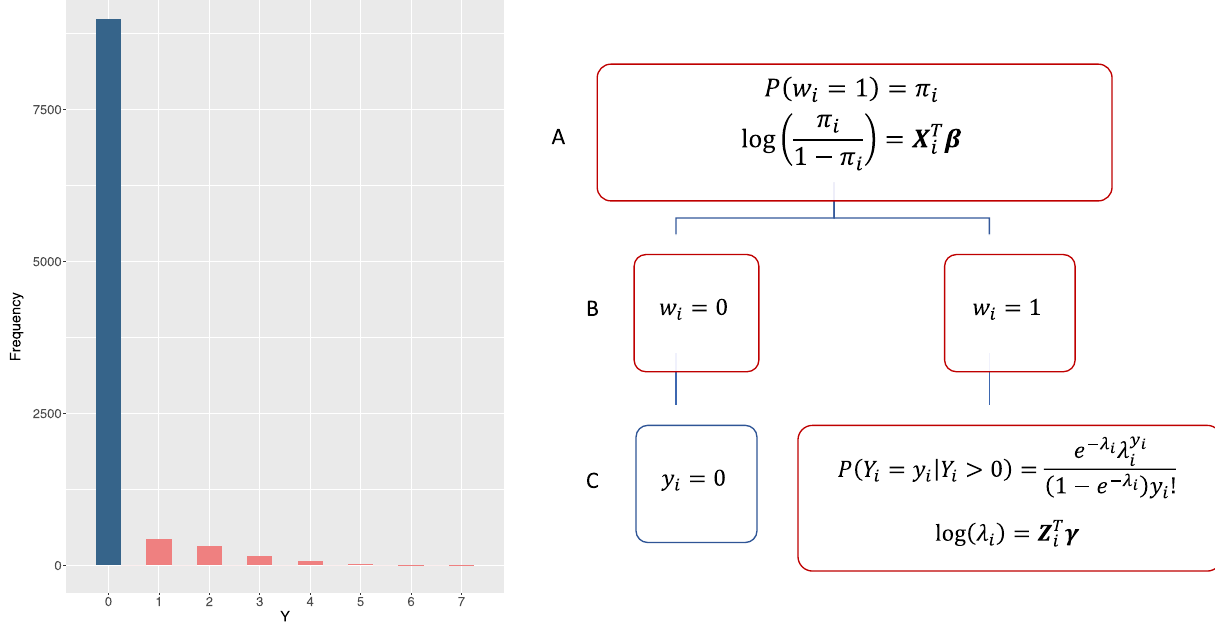
Figure 1. On the left, a histogram displaying counts generated with a Poisson–Logit hurdle distribution with 10% prevalence and a zero-truncated event rate of (cid:31) = 1.5 . On the right, a hierarchical diagram visualizing the data generation process in a Poisson–Logit hurdle framework. Independent realizations w i ∈ { 0, 1 } are generated from a Bernoulli process, with underlying probability π i modeled using a logit link. Realizations where w i = 0 are zero counts ( y i = 0 ), while realizations where w i = 1 are positive counts ( y i ∈ { 1, 2, . . . } ). The positive counts are generated by a zero-truncated Poisson distribution, with underlying event rate (cid:31) i modeled using a log